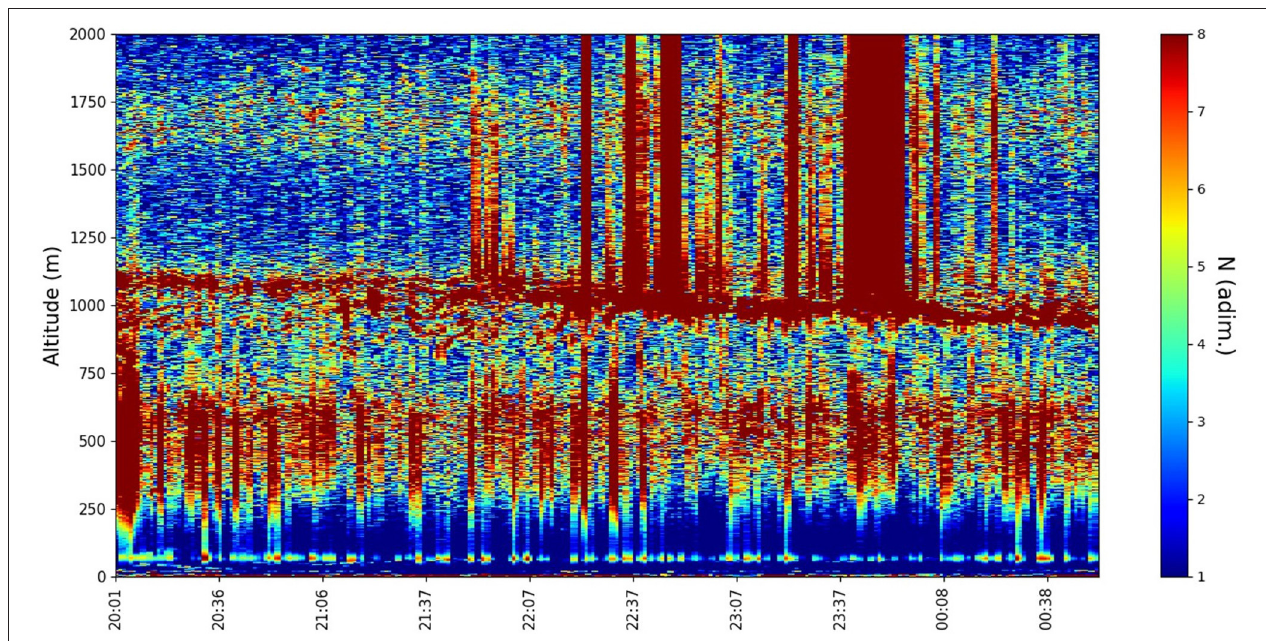
FIGURE 8 | N ( z ) timeseries on the 28th of May 2017 calculated with multifractal theory and lidar-obtained length scales; temporal resolution: 3min; spatial resolution: